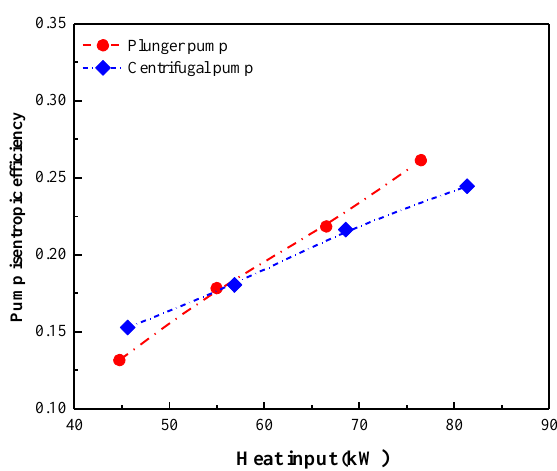
ffi ciency with heat input using the plunger pump and centrifugal Figure 8. Pump isentropic efficiency with heat input using the plunger pump and centrifugal pump. Figure 8. Pump isentropic e